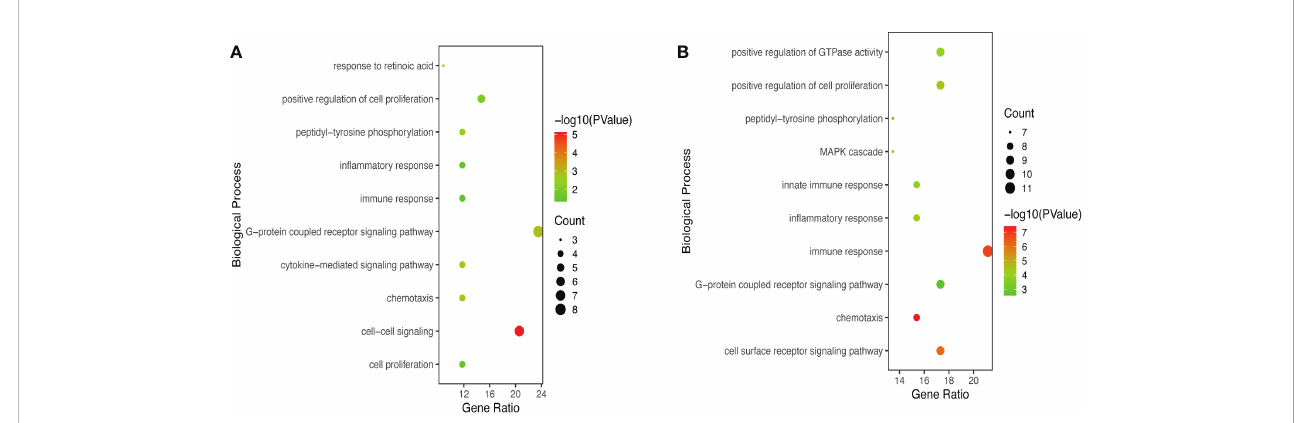
FIGURE 3 Signi fi cant enriched biological process (BP) terms between monosomy X TS patients and normal individuals. (A) The top 10 BP terms in DEIRGs of Xm TS patients compared with normal individuals. (B) The top 10 BP terms in DEIRGs of Xp TS patients compared with normal